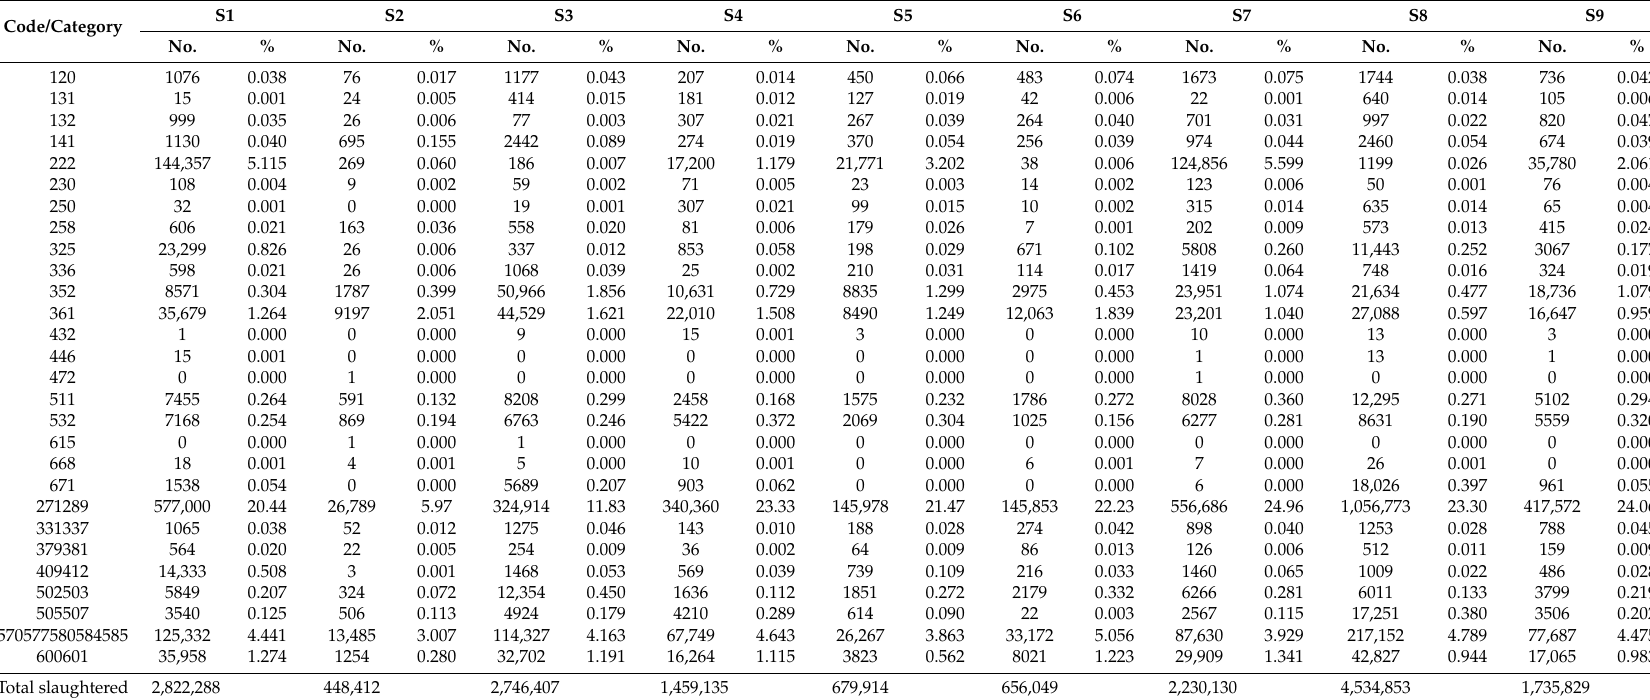
Table 1. Prevalence (number and %) of selected slaughter recording codes in slaughter pigs slaughtered at the nine largest slaughterhouses (S1–S9) in Denmark in